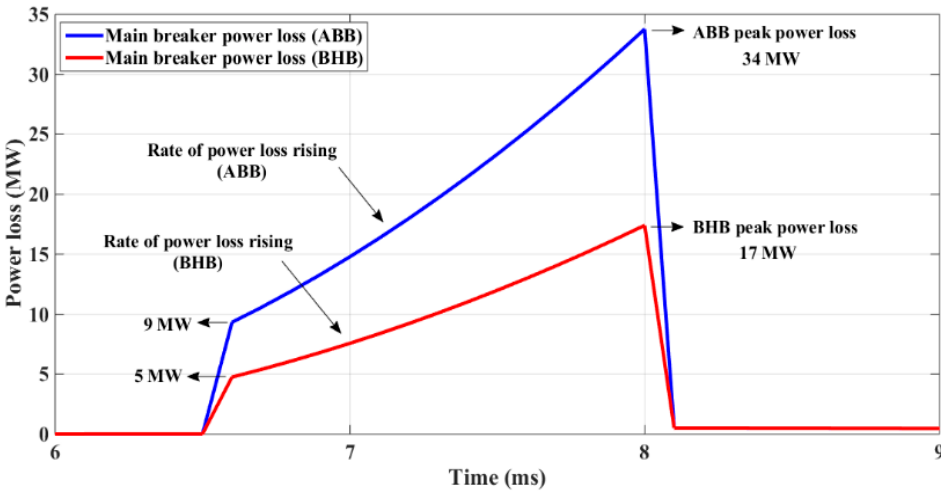
Figure 7. Comparison of the BHB and hybrid breaker power